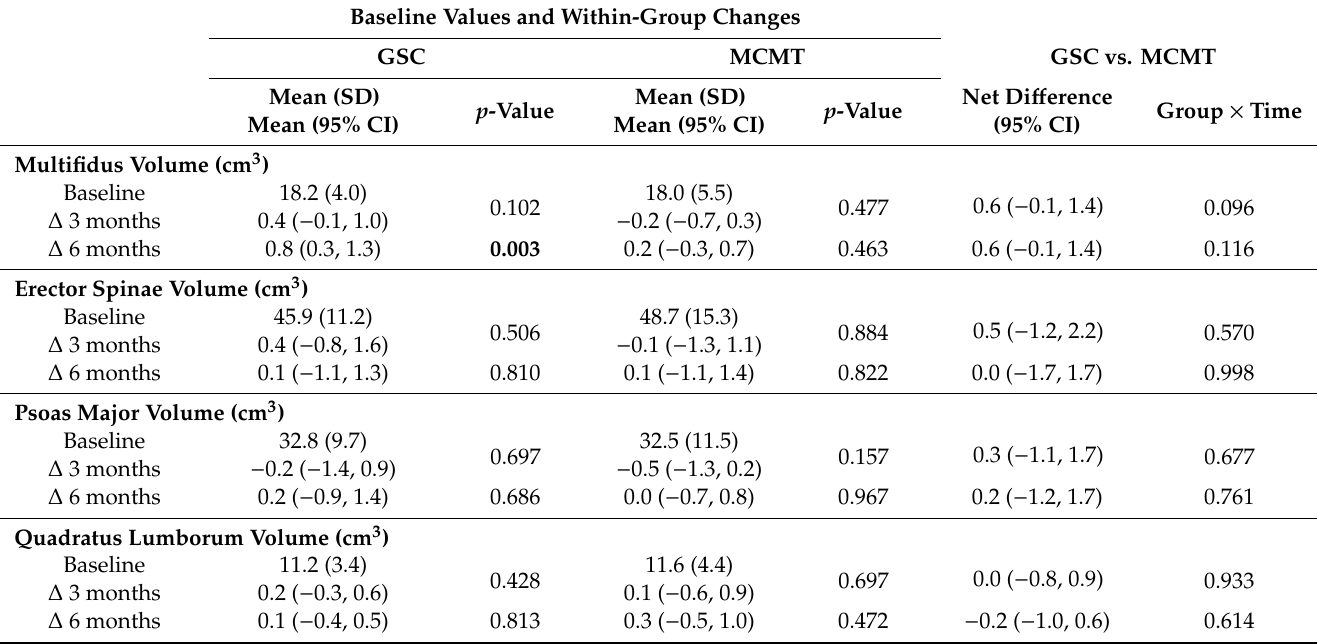
Table 4. Intent-to-treat analysis using linear mixed models on average total of multifidus, erector spinae, psoas major and quadratus lumborum volume at baseline, three and six months in participants randomized to motor control manual therapy (MCMT) and general strength and conditioning